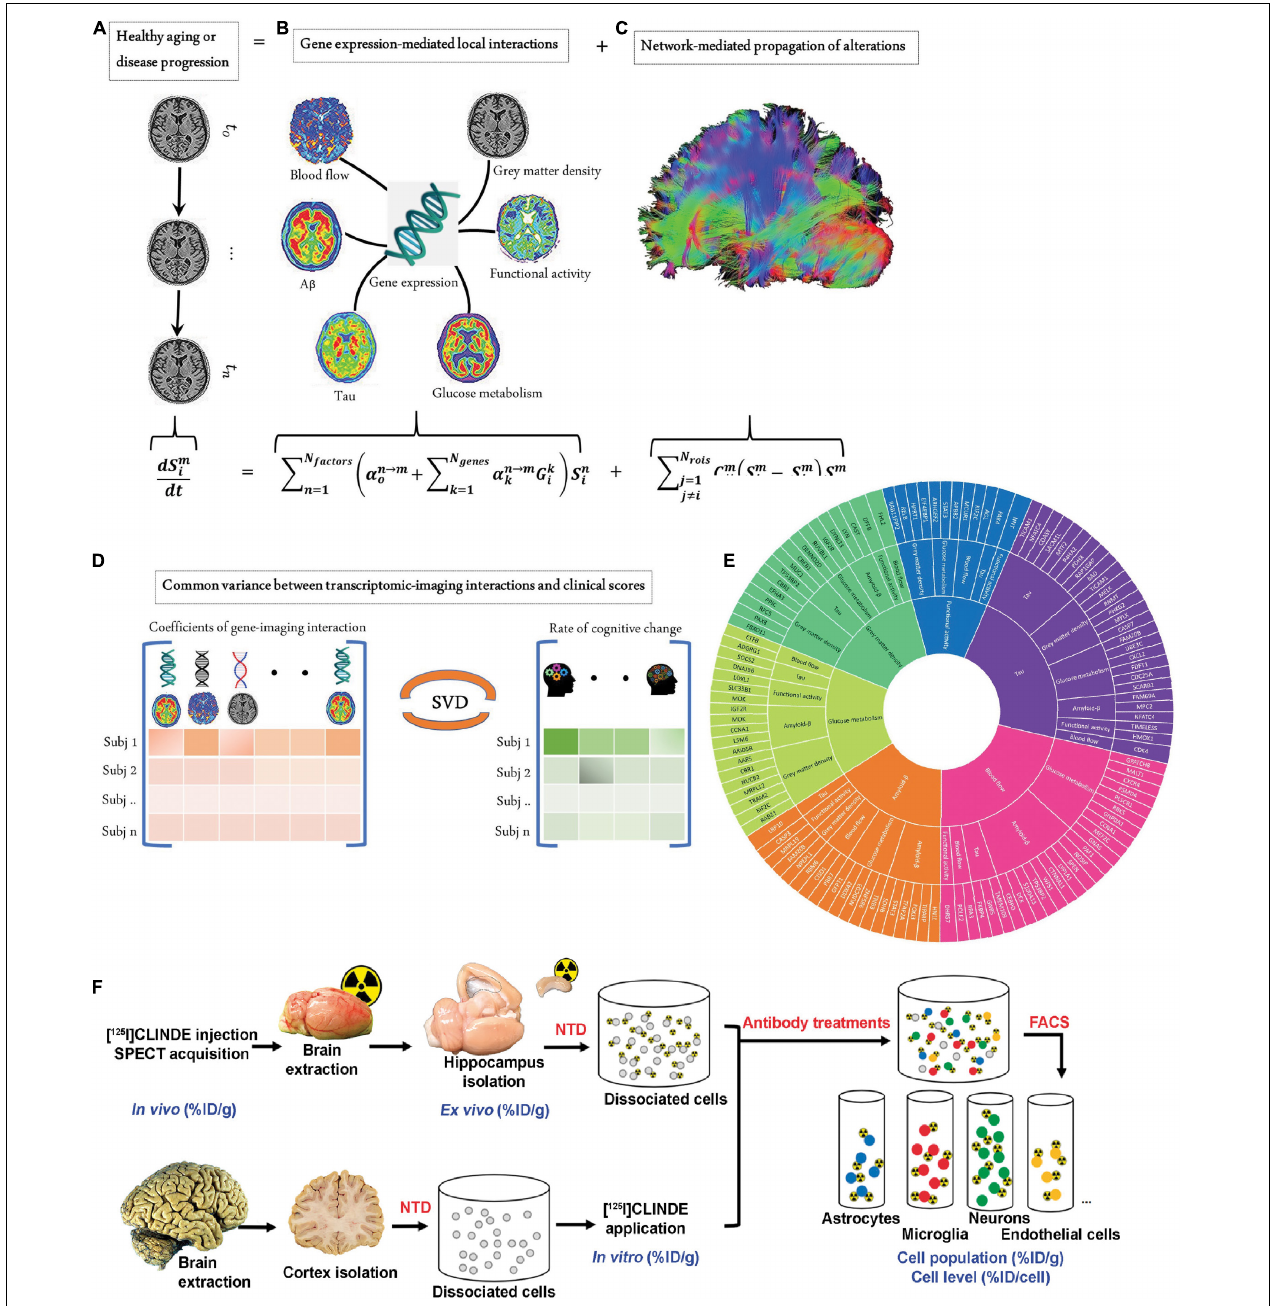
FIGURE 2 | Measures to close biological gaps. (A–E) Integrated transcriptomic and neuroimaging data to understand biological mechanisms in aging and Alzheimer’s disease. (A) The longitudinal alteration of macroscopic biological factors in healthy and diseased brains due to gene-imaging interactions and the propagation of the ensuing alterations across brain networks. (B) Regional multifactorial interactions between six macroscopic biological factors/imaging modalities are modulated by local gene expression. (C) Causal multifactorial propagation network capturing the interregional spread of biological factor alterations through physical connections. (D) By applying a multivariate analysis through singular value decomposition (SVD), the maximum cross-correlation between age-related changes in cognitive/clinical evaluation and the magnitude of genetic modulation of imaging modalities was determined in a cohort of stable healthy subjects (for healthy aging), mild cognitive impairment (MCI) converters, and Alzheimer’s disease (AD) subjects (for AD progression). (E) The key causal genes driving healthy aging and AD progression are identified through their absolute contributions to the explained common variance between the gene-imaging interactions and cognitive scores. Reproduced from (148) with permission from eLife Sciences Publications, Ltd. (F) Overview of the fluorescence-activated cell sorting to radioligand-treated tissues (FACS–RTT) protocol. Schematic overview of the methodology used for the in vivo , ex vivo, in vitro and cellular measurement of the radioligand. % ID/cell: percentage of the injected dose/cell; % ID/g: percentage of the injected dose/g tissue weight; NTD: neural tissue dissociation. Reproduced from (120) with permission from Sage Publication.